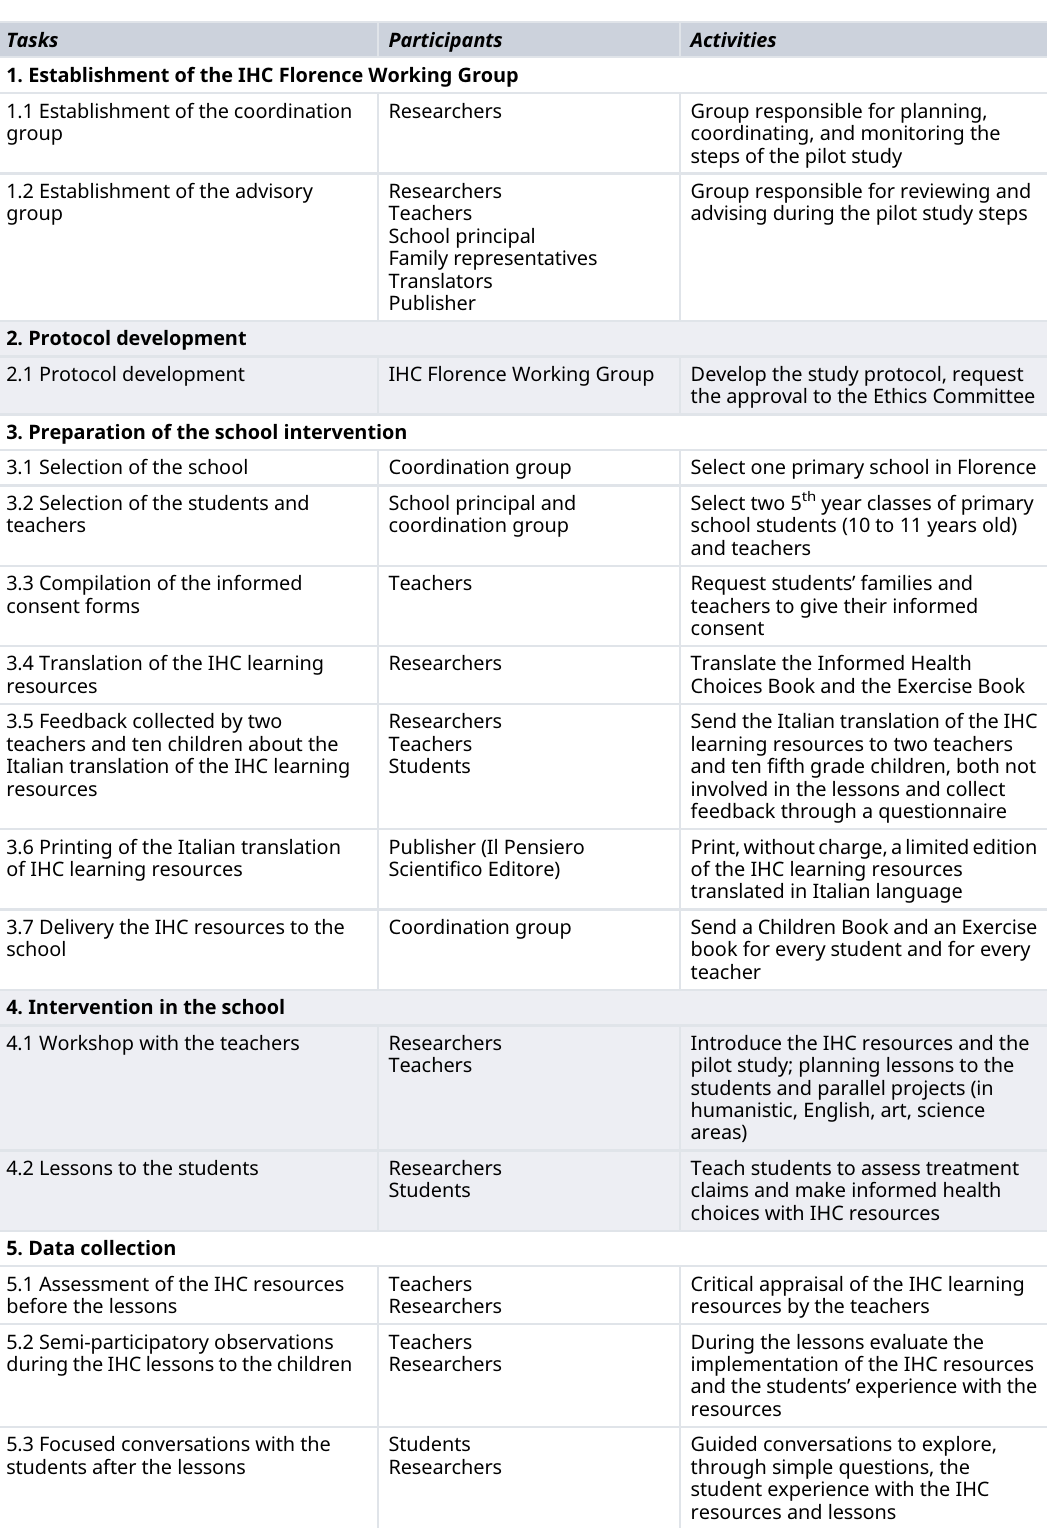
Table 2. Pilot study tasks.